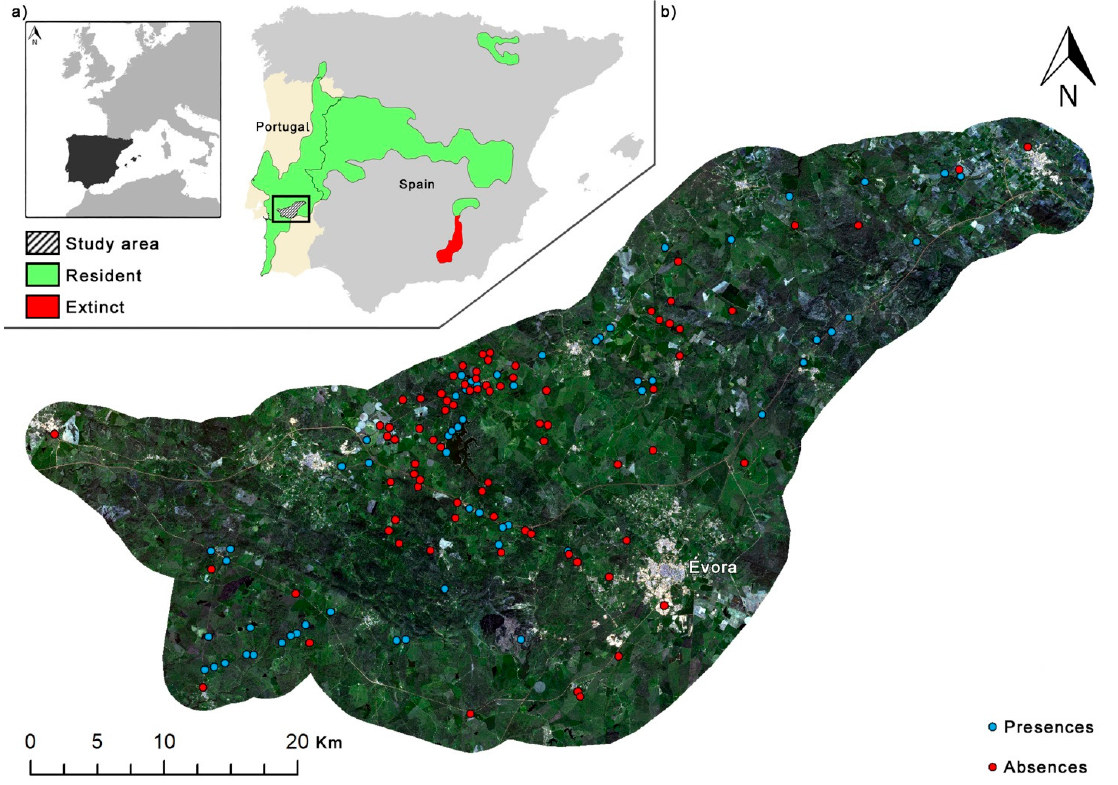
Figure 1. Location of the study area: ( a ) Iberian Peninsula and actual Cabrera vole distribution range are represented jointly with the study area, located within the Alentejo region (Southern Portugal); and ( b ) Cabrera vole sampling points layered with the T29SNC, T29SND, T29SPC, and T29SPD Sentinel-2A RGB composite imageries delimited by the study area.